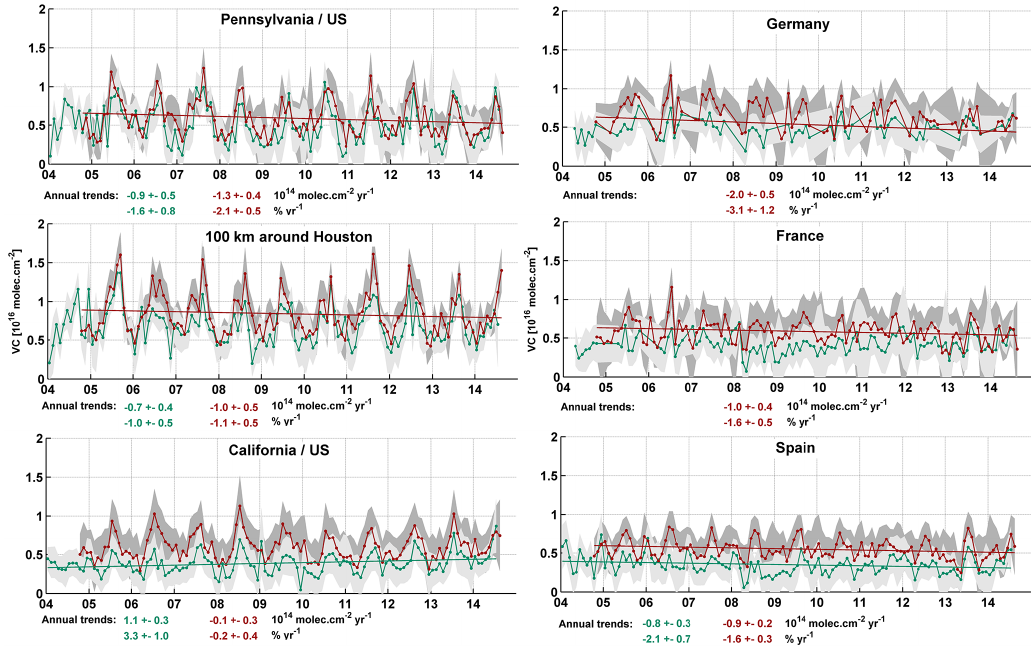
Figure 16. Monthly averaged H 2 CO vertical columns as observed from satellite instruments in US and Europe. Mid-morning columns (in green) consist of SCIAMACHY (2003–2011) and GOME-2A (2007–2013) and GOME-2B (2013– ) measurements, while early afternoon columns (in red) are derived from OMI measurements. If statistically significant, results of the trend analysis are displayed (De Smedt et al., 2010).